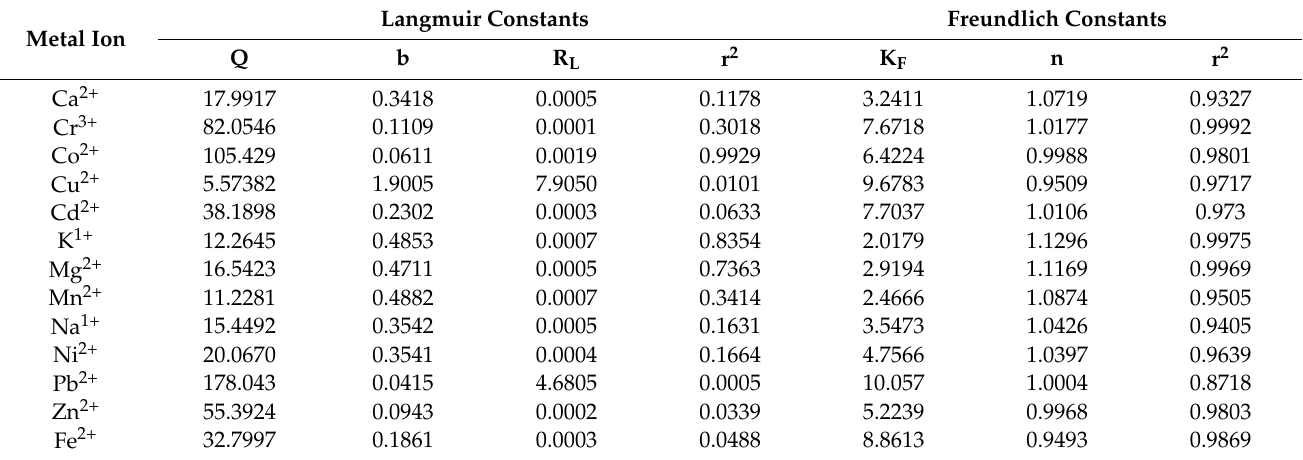
Table 2. Langmuir and Freundlich isotherm parameters for the adsorption of metal ions onto Aerva javanica .